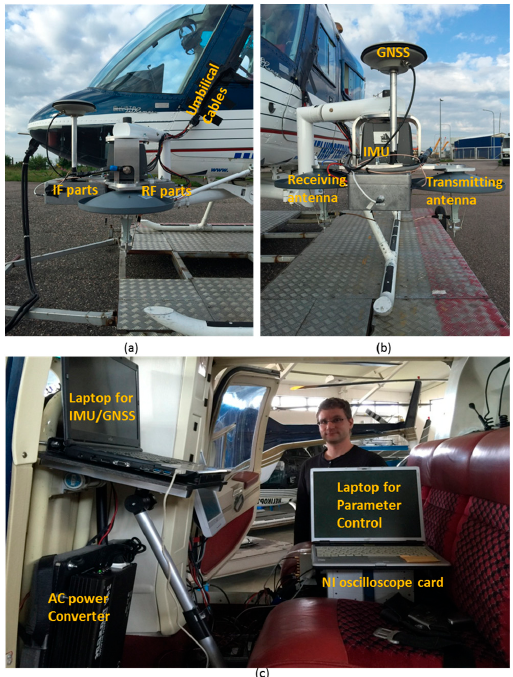
Figure 6. Mounting of the equipment on the helicopter: ( a ) side view; ( b ) front view; ( c ) inside cabin.